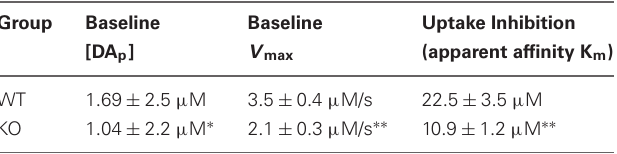
under baseline conditions and in response to cocaine.